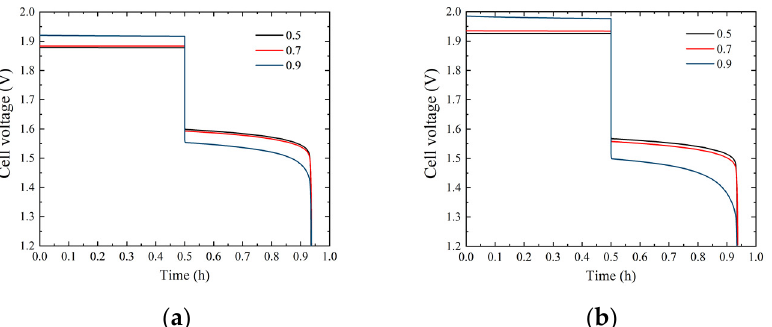
Figure 11. Ba tt ery voltages with di ff erent electrode porosities at current densities of ( a ) 20 mA cm (cid:2879)(cid:2870) Figure 11. Battery voltages with different electrode porosities at current densities of ( a ) 20 mA cm − 2 and ( b ) 40 mA cm (cid:2879)(cid:2870) . and ( b ) 40 mA cm − 2 .